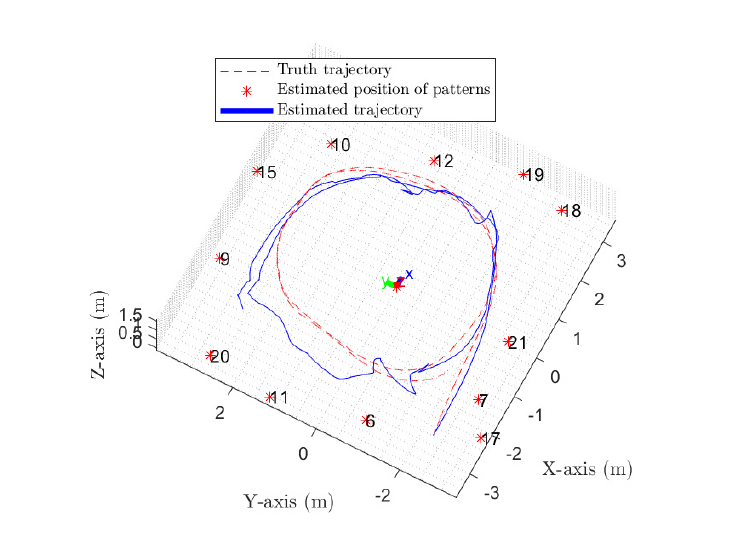
Figure 10. Estimated trajectory for EKF–VSLAM .